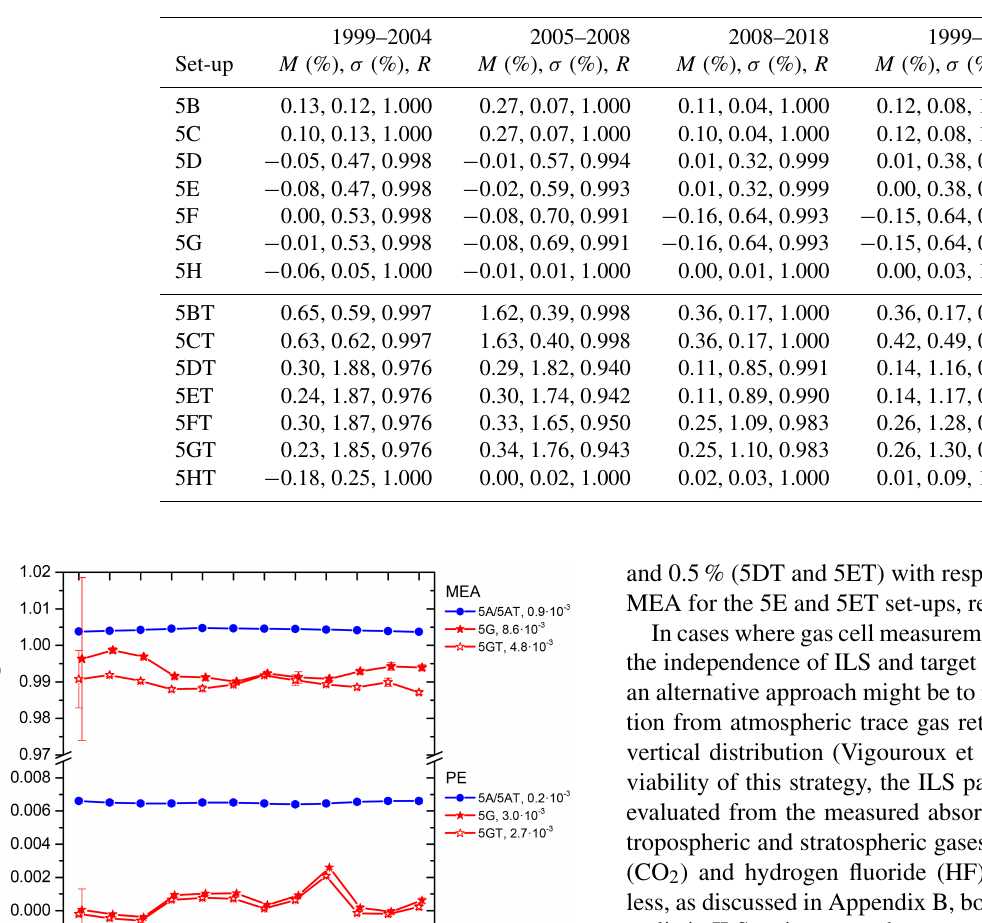
Table 3. Summary of statistics for the O 3 TC comparison for the set-ups 5B, 5BT, 5C, 5CT, 5D, 5DT, 5E, 5ET, 5F, 5FT, 5G, 5GT, 5H, and 5HT with respect to 5A and 5AT: median ( M , in %) and standard deviation ( σ , in %) of the relative differences (RD, 5X and 5XT to 5A series (1999–2018). The number of quality-filtered measurements is 466, 683, and 3775 for the three periods, respectively, and 4924 for the whole dataset.